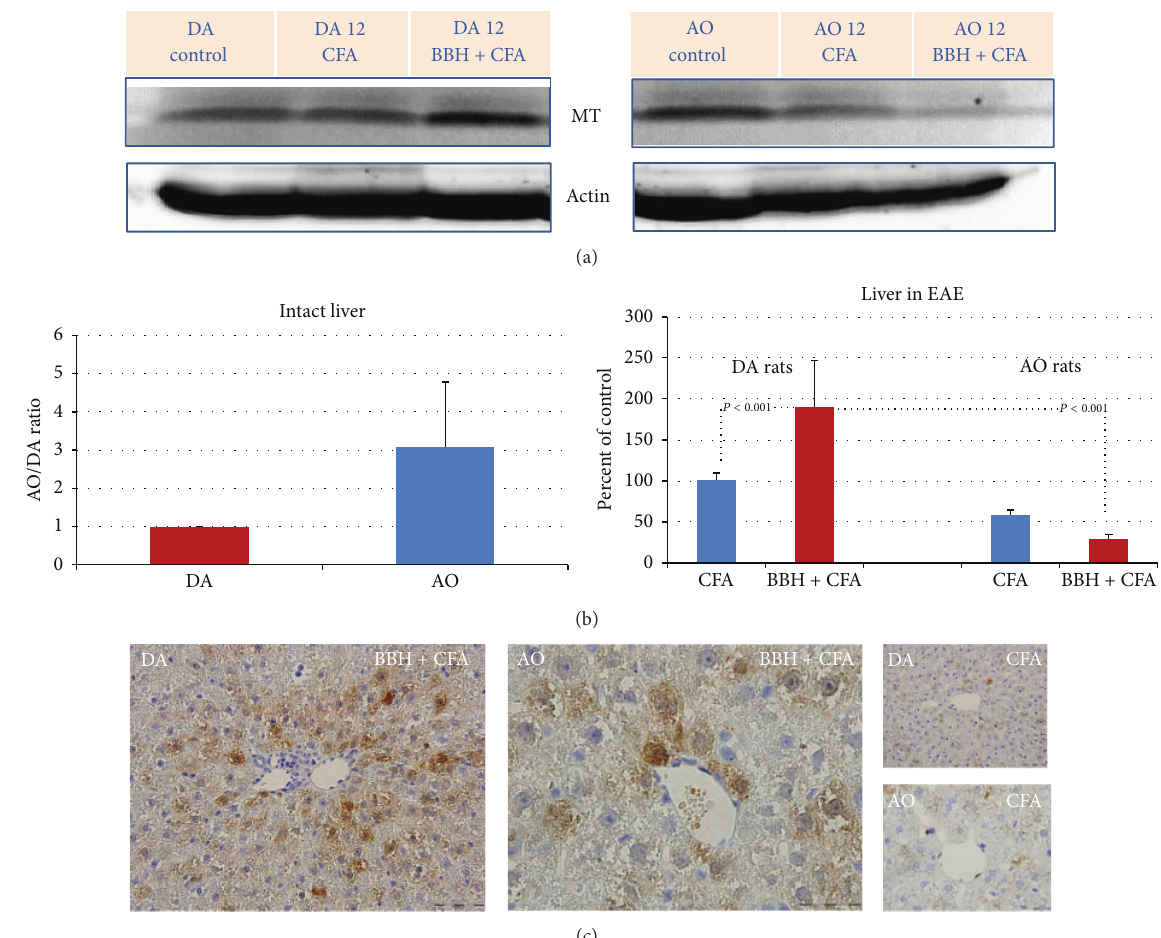
Figure 1: Expression of MT I+II proteins in the livers of EAE-prone DA and EAE-resistant AO rats. (a) Representative western blots indicate the MT I/II protein ( ∼ 14kD; range 10–15 kD) detected by anti-MT MoAbs. The liver samples were obtained from intact rats and from rats treated by bovine brain homogenate (BBH) and complete Freund’s adjuvant (CFA) or by CFA at the time of first attack in EAE-prone rats (day 12). As a loading control the blots of 𝛽 -actin protein (37–50 kD) are shown. (b) Relative protein expression is shown as AO/DA ratio (intact liver) and as the percent of control (liver in EAE). All band densities were normalized corresponding to 𝛽 -actin. Analyses were made in tissue samples, prepared as a pool from 3 rats in three independent experiments. Data represent mean ± SE. (c) Representative immunohistochemical staining of MT I/II proteins in paraffin-embedded sections of the liver tissue in DA and AO rats after treatment with BBH+CFA or CFA. The results are representative findings of 3